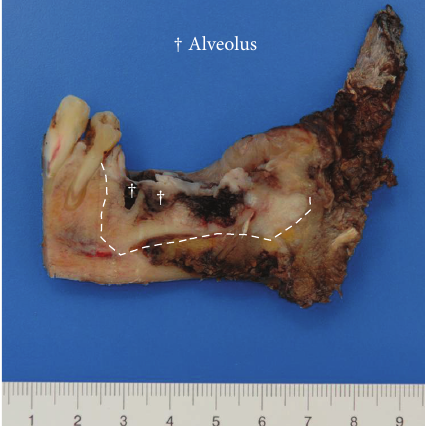
Figure 10: Case 3—the sagittal split preparation of the resection specimen from a lingual view clearly shows the association of the tumor (borders marked with lines) to the dental alveoli ( † ) of the distal molars. The teeth 36 and 37 are lost due to the preparation